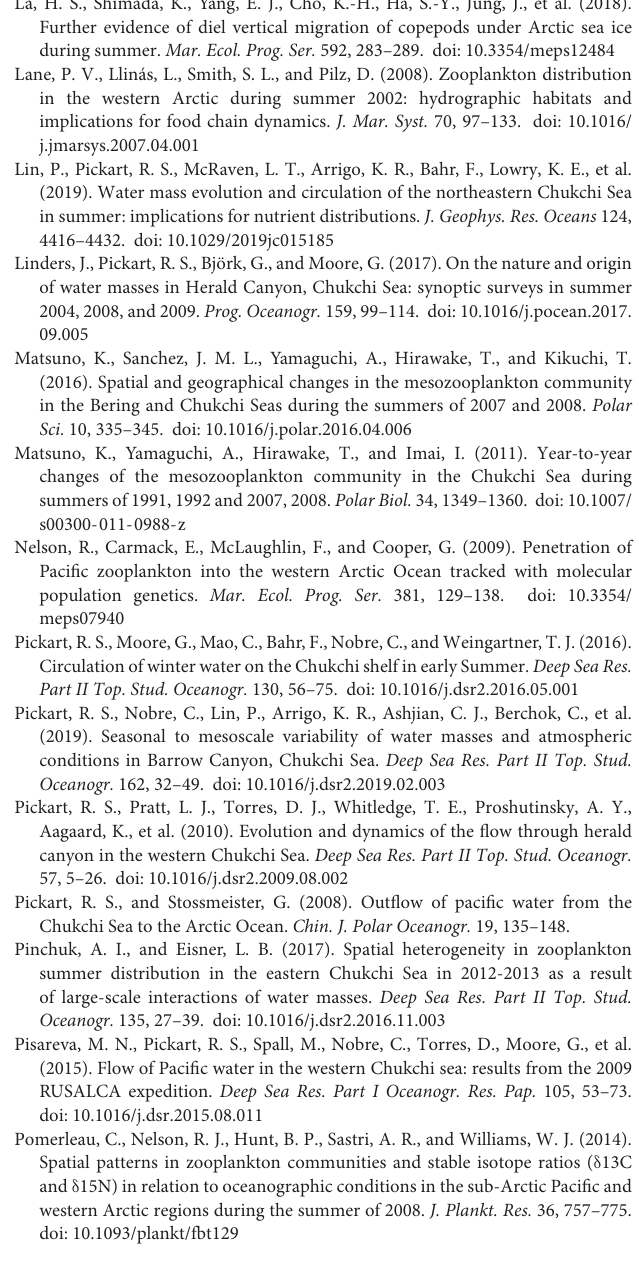
FIGURE S1 | T-S Diagram of CTD (Bottom to Top) for the Southern Chukchi Sea 2014–2016. FIGURE S2 | Pacific copepod species abundance in the Chukchi Sea after 1946. Each white symbol represents previous cruise, the red one represents the present study in 2015. The dashed line shows a fitted linear trend over averaged